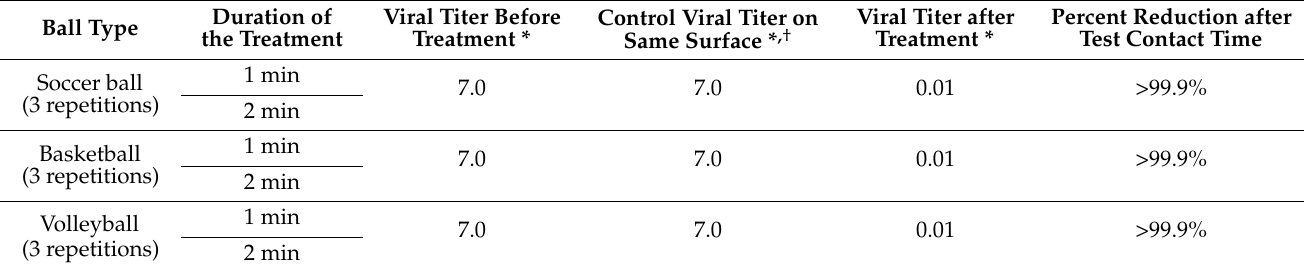
Table 2. Results of the SARS-CoV-2 virucidal tests carried out on the surface of different sport balls. Duration of Ball Type the